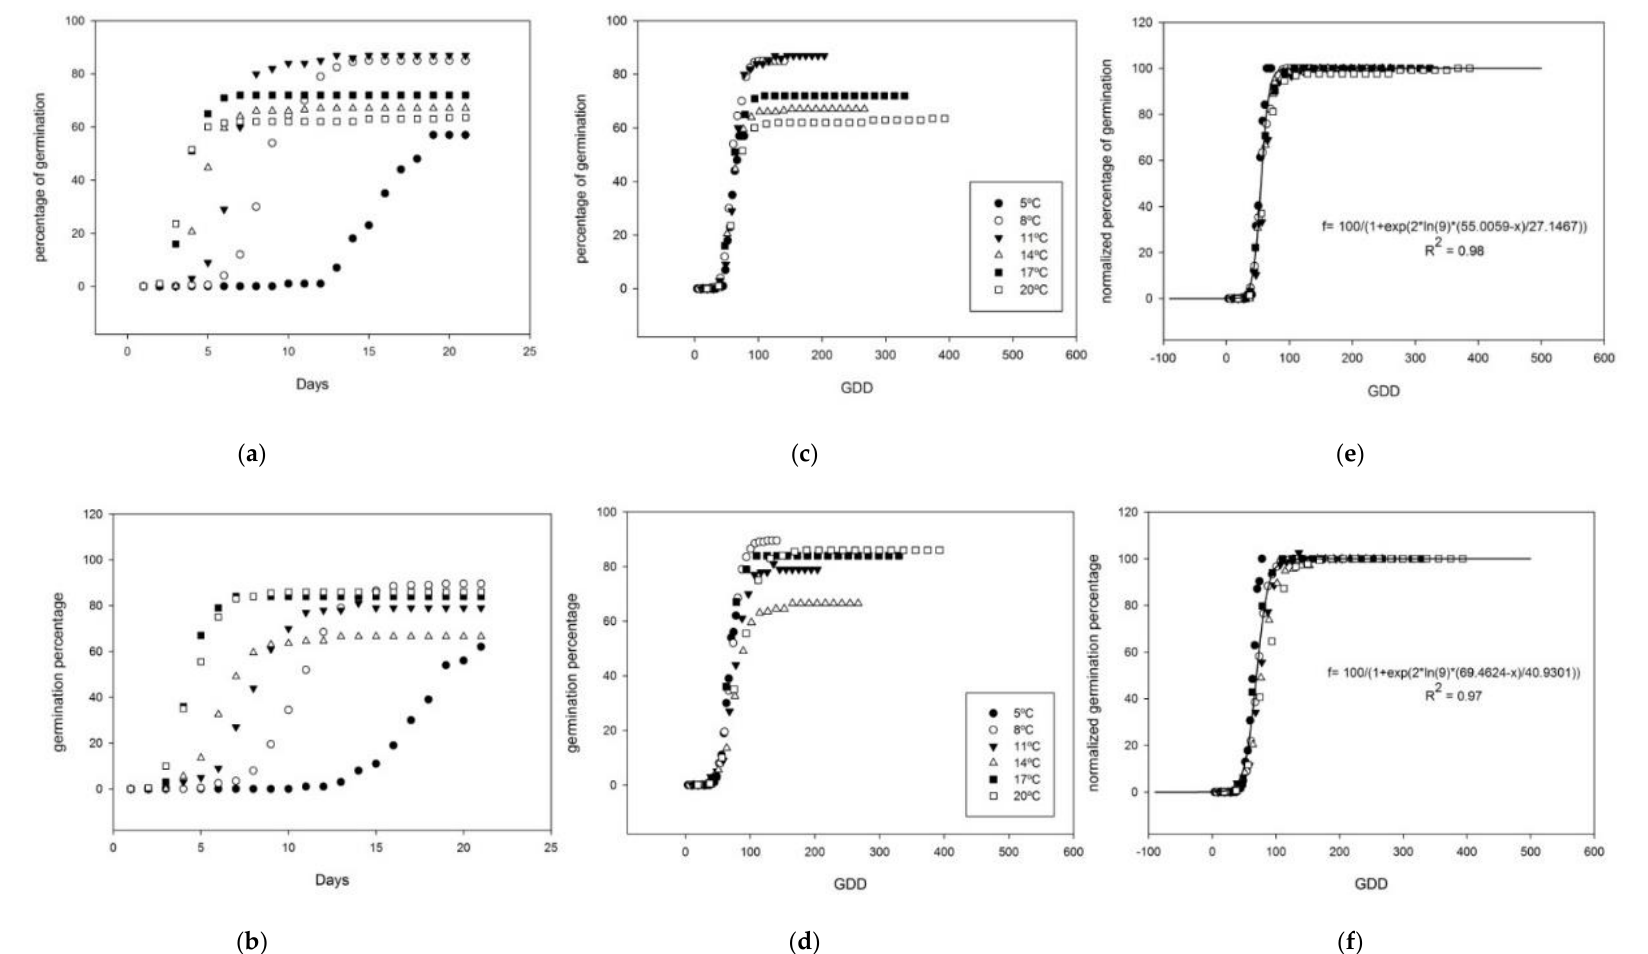
Figure 2. Cumulative germination seeds of Thlaspi arvense from Teruel produced at Morris. ( a ), apical, and ( b ), basal, seed germination percentages are shown against days after sowing; ( c ), apical, and ( d ), basal seed germination percentages shown against growing degree days (T b = 1.29 °C and 1.62 °C, respectively, for basal and apical seeds); ( e ), apical, and ( f ), basal seed germination percentages as shown as normalized values to 100%. In ( e ) and ( f ), the Boltzmann formula for the germination model is provided for both apical and basal seeds, respectively, with the corresponding R 2 .